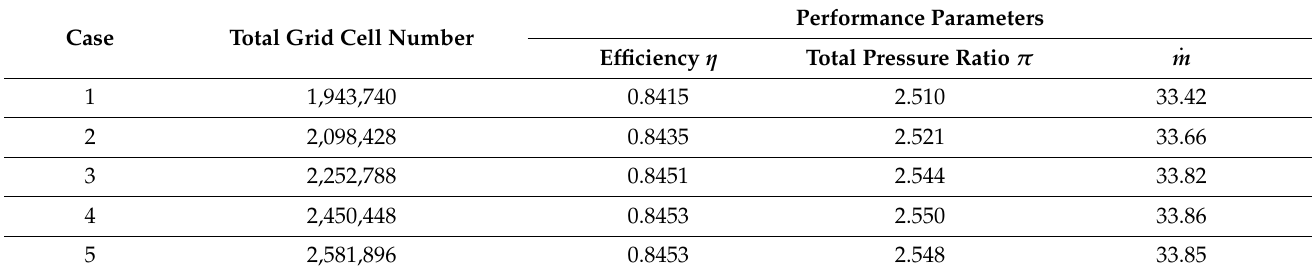
Table 2. Grid independence verification at the design point.